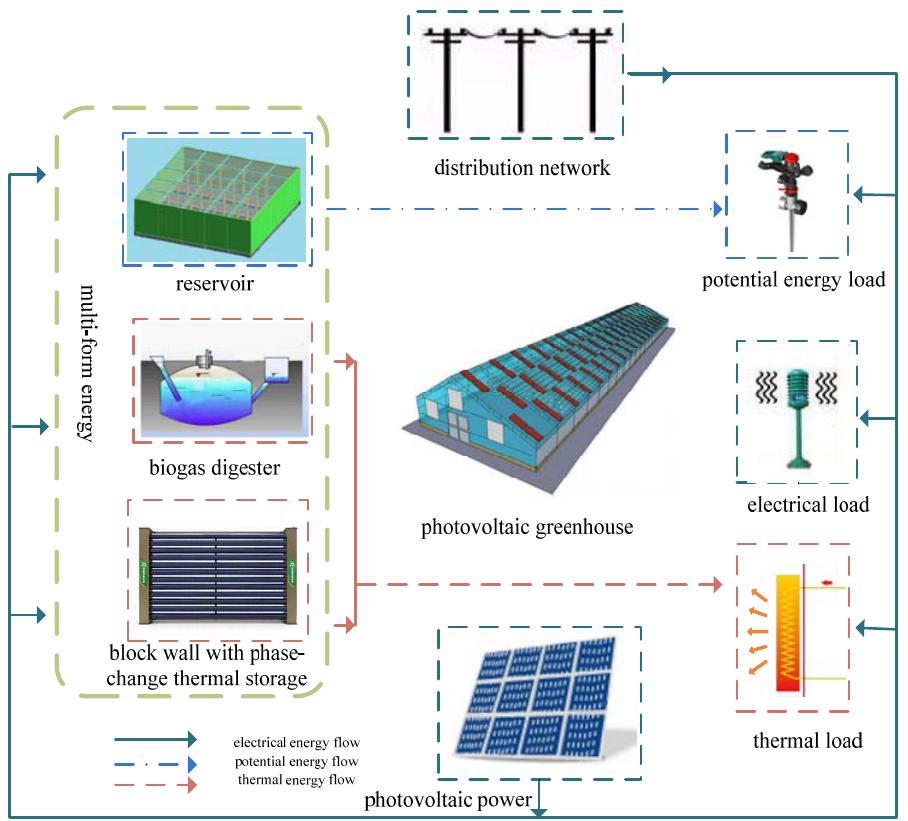
Figure 1. Schematic diagram of the typical structure of facility agriculture micro energy network with photovoltaic greenhouse.